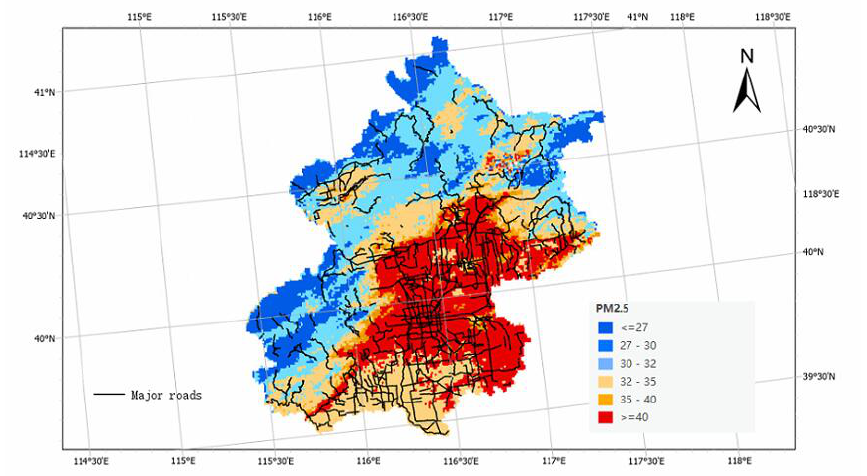
Figure 9. Annual mean estimated PM 2.5 concentrations. The black lines are major roads in